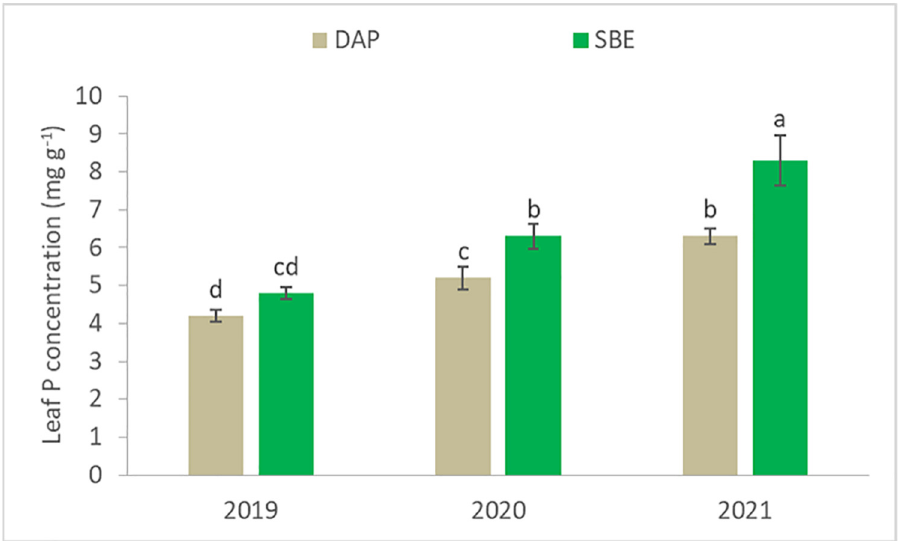
Figure 2. Leaf P concentration: fertilizer × year interaction. The error bars represent the standard error of the means and the letters above the histograms correspond to the ranking of the Fisher’s protected test at p < 0.05.